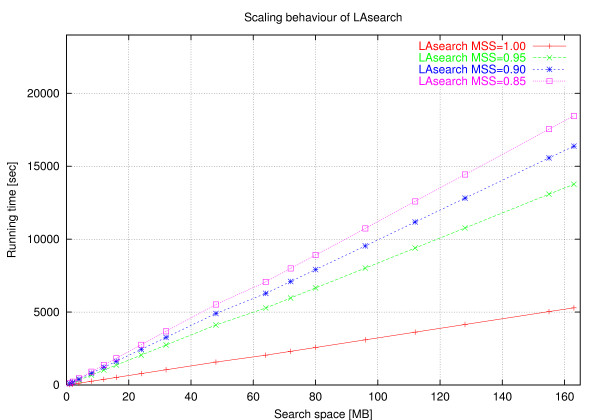
Scaling behaviour of LAsearch. Experiment 7: Scaling behavior of LAsearch when searching with 576 TRANSFAC PSSMs on subsets of human chromosome 6 of different sizes and with different matrix similarity cutoff values (MSS). The subsets are prefixes of human chromosome 6 of length 2k for k = 0, 1, 2,..., 7.